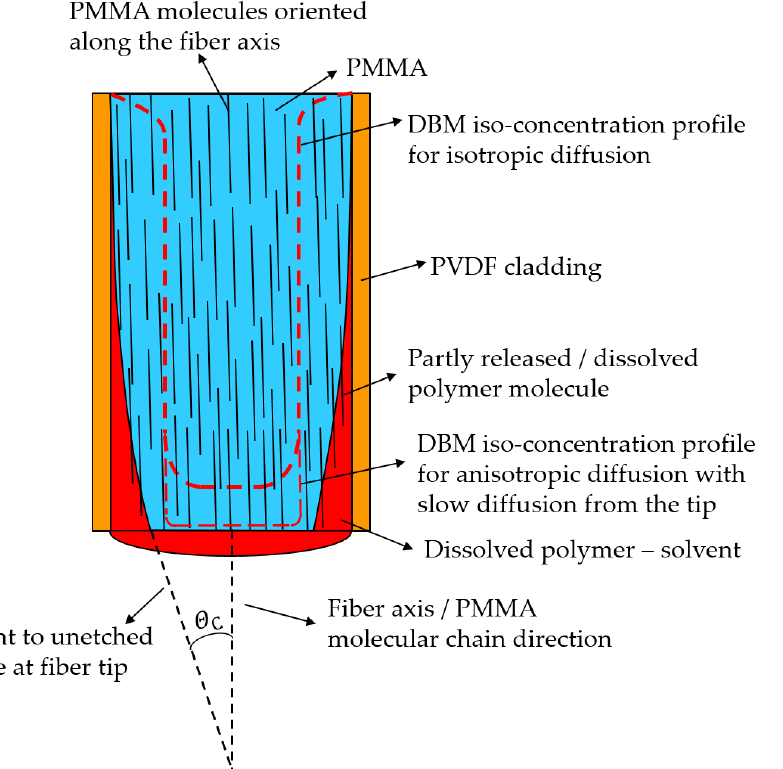
Figure 3. Sketch illustrating the proposed etch mechanism. Only the dipped section of the fiber is shown. Note that the etched fiber tip shape is not following a DBM iso-concentration profile. This is due to PMMA molecular orientation along the fiber axis originating from the fiber drawing process determining local etch speed and combined cladding and dissolved polymer buoyancy restriction of polymer transport away from the fiber.